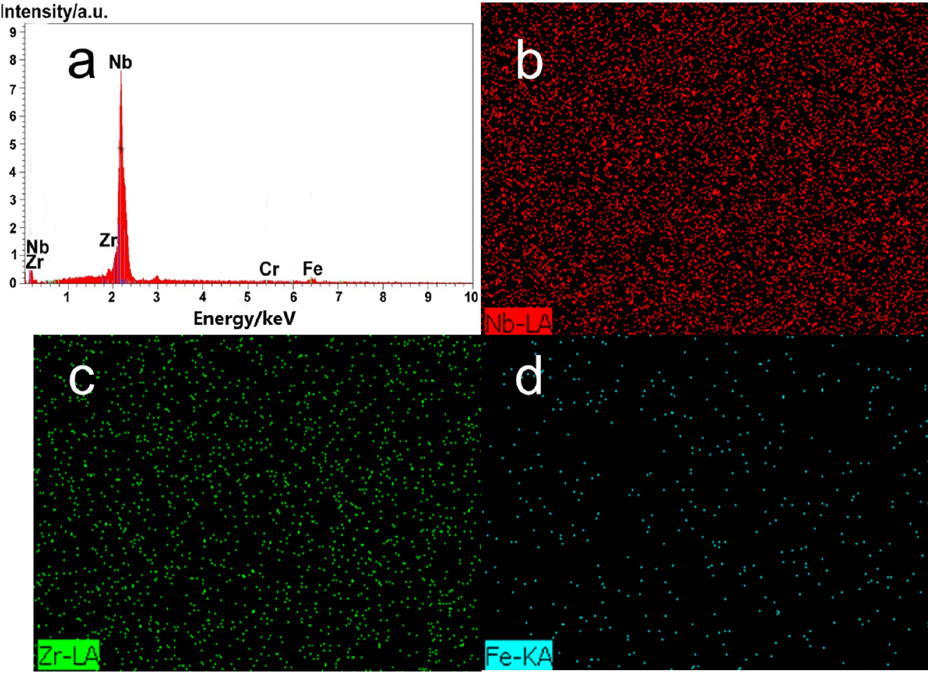
Figure 4. EDS element distribution: ( a ) energy spectrum, ( b ) Nb, ( c ) Zr, and ( d ) Fe of Nb ‐ Zr alloying layer prepared at a pressure of 40 Pa. Table 2. Element contents of Nb ‐ Zr alloying layer prepared at a pressure of 40 Pa.